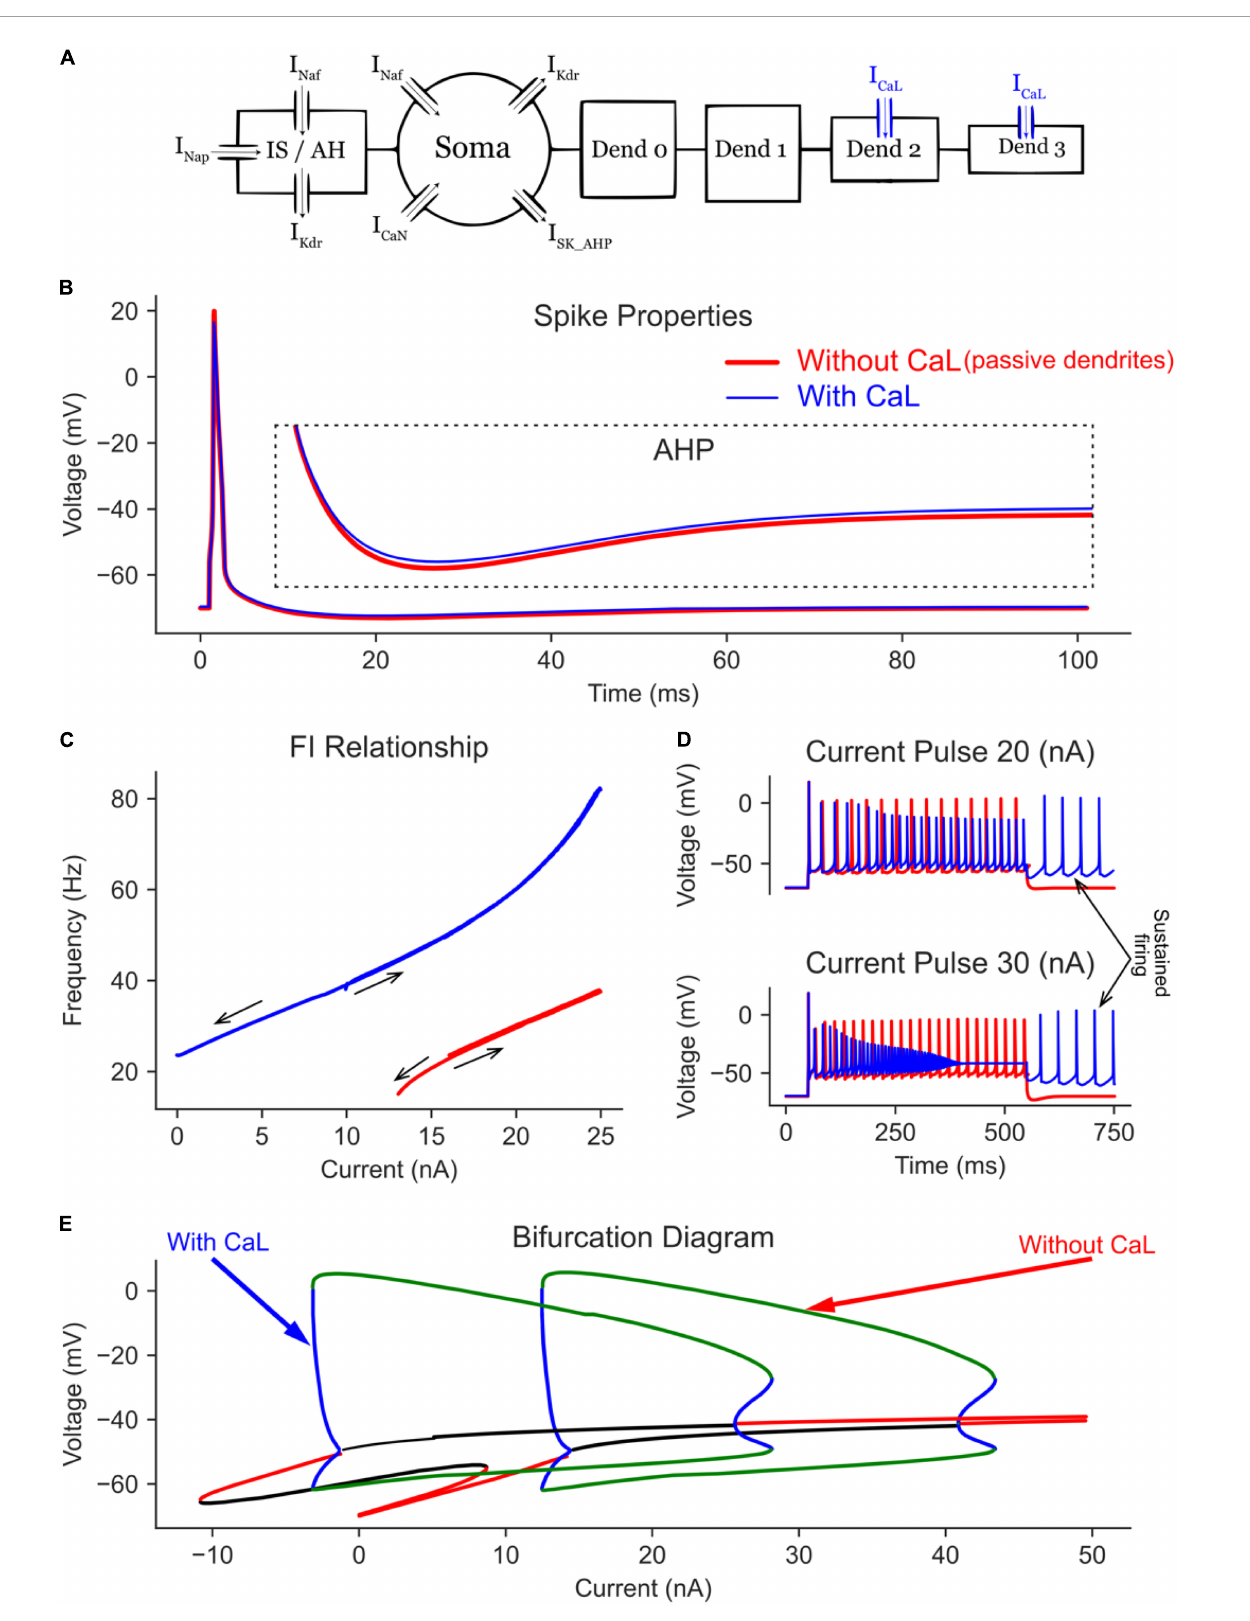
FIGURE4 The effect of dendritic L-type Ca channels on the MN model bifurcation diagram. (A) The 6C model morphology and the ion channels involved. Note that all compartments have leak channels, but CaL channels are on dend 2 and 3 only. The AP and AHP shapes (B) , F-I relationship (C), and MN repetitive firing on long pulses (D) with (blue traces) and without (red traces) the dendritic L-type Ca channels included in the model. (E) The V-I bifurcation diagram of the MN model with and without the dendritic L-type Ca channels. In the diagram, the green and blue traces indicate the extrema of the stable and unstable limit cycles, respectively. The red and black traces show stable and unstable equilibrium points,